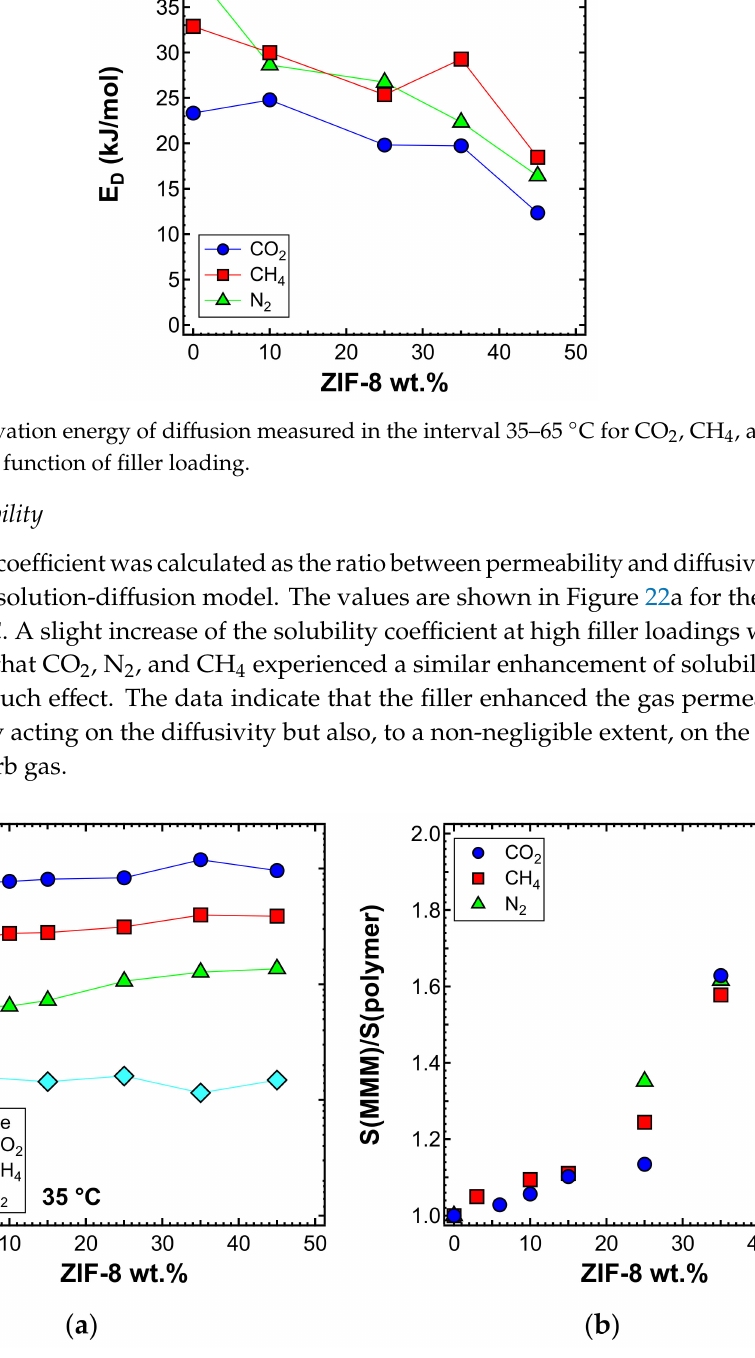
Figure 22. Estimated solubility ( a ) and solubility ratio ( b ) at 35 ◦ C in the mixed-matrix membranes inspected. Values evaluated as P /